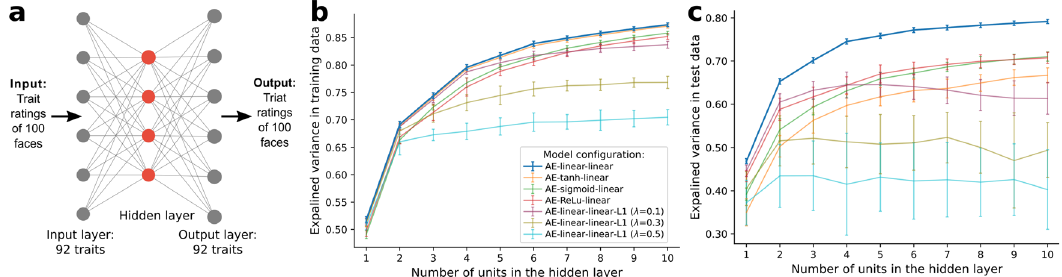
Fig. 4 Dimensionality analysis with arti fi cial neural network and cross-validation. a An example of an autoencoder model with one hidden layer and four neurons in the hidden layer to learn the underlying representation of the data. b , The means (points) and standard deviations (bars) of the explained variance ( n = 50 iterations) on the training data from autoencoders with various numbers of neurons in the hidden layer (red dots in a). Colors indicate different con fi gurations of activation functions in the encoder and decoder layers (linear, tanh, sigmoid, recti fi ed linear activation unit, L1-norm regularization); for example, the blue line indicates con fi gurations with linear functions in both the encoder and decoder layers (AE-linear-linear). c , Means (points) and standard deviations (bars) of the explained variance ( n = 50 iterations) on the test data from autoencoders shown in b . Source data are provided as a Source Data fi le. Table 1 Factor loadings from EFA on the subset of 13 traits used in the 2D framework. Factor loadings from EFA on the subset of data corresponding to 13 traits ( fi rst column) that are the same or most similar to those used in a prior study that discovered the popular 2D framework[1] ( fi rst column, in brackets). Two factors — the optimal number of factors as indicated by both the Cattell ’ s Scree Test and empirical BIC — were extracted and rotated with oblimin. The largest absolute loading across factors for each trait is highlighted in bold. Source data are provided as a Source Data fi